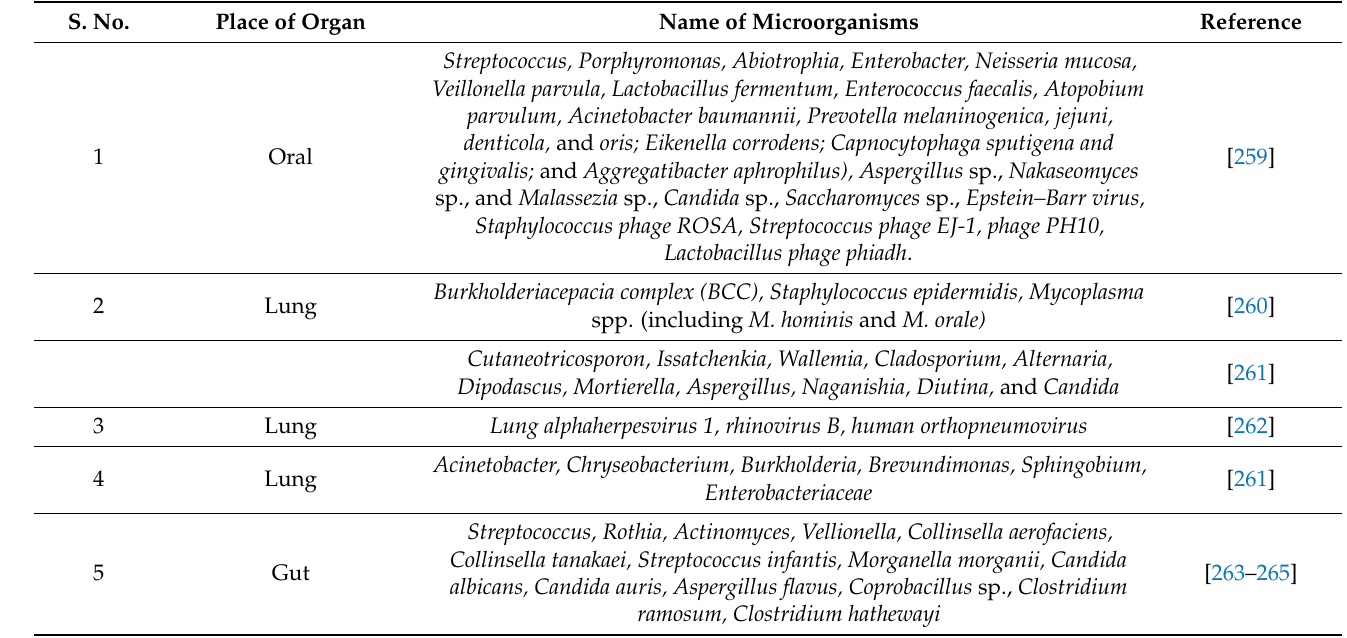
Table 2. Microorganisms involved in the pathogenesis of